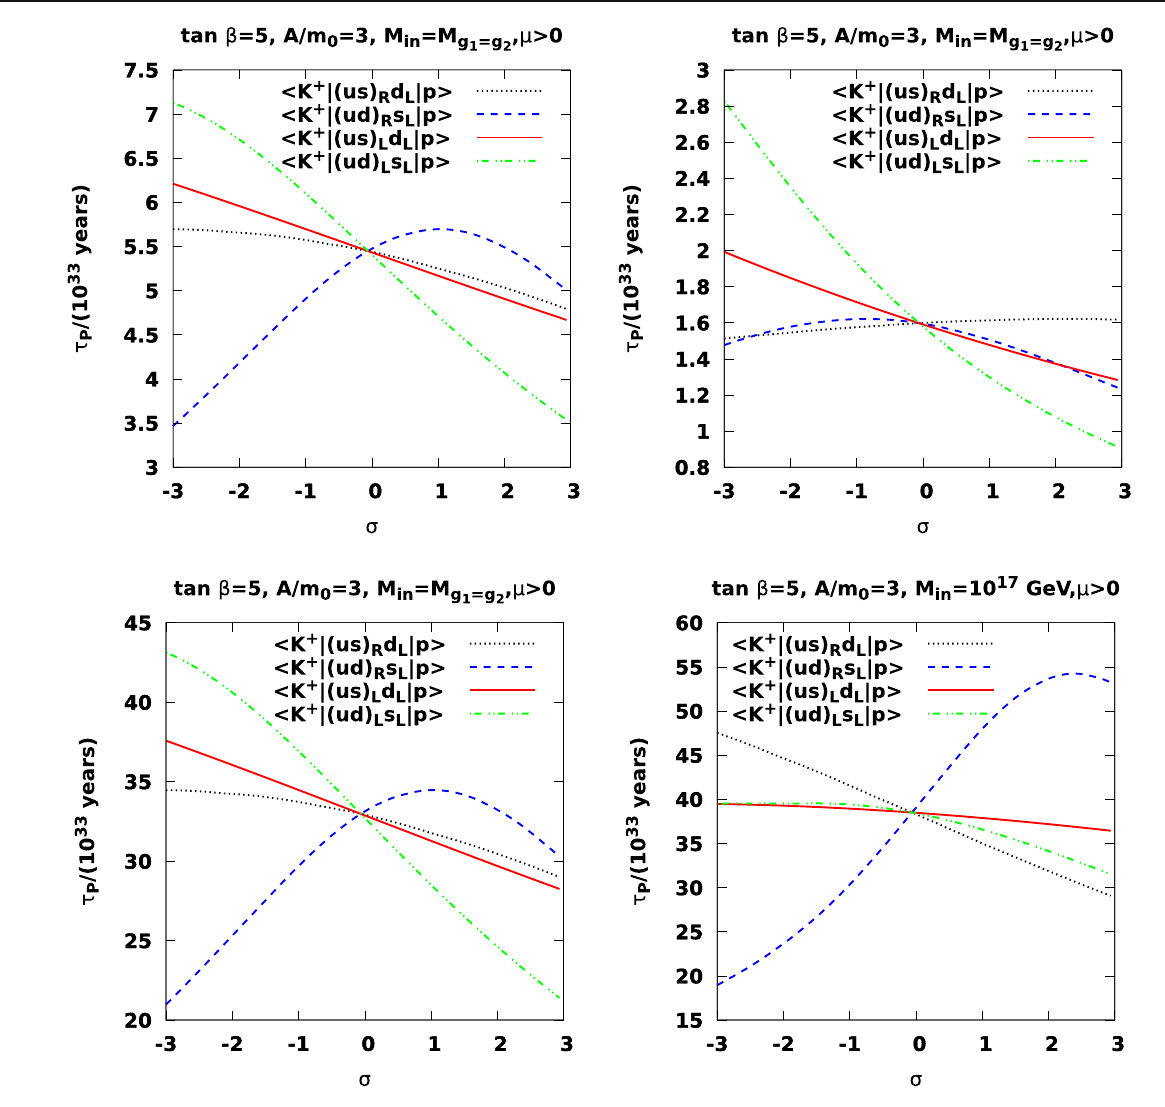
Fig. 1 Sensitivities of the proton decay rate to variations in units of the standard deviations of the matrix elements of the indicated 3-quark operators. In all cases, we chose reference points with tan β = 5, A 0 / m 0 = 3, m 1 / 2 = 9 . 79 TeV and μ > 0. We also chose (in TeV)